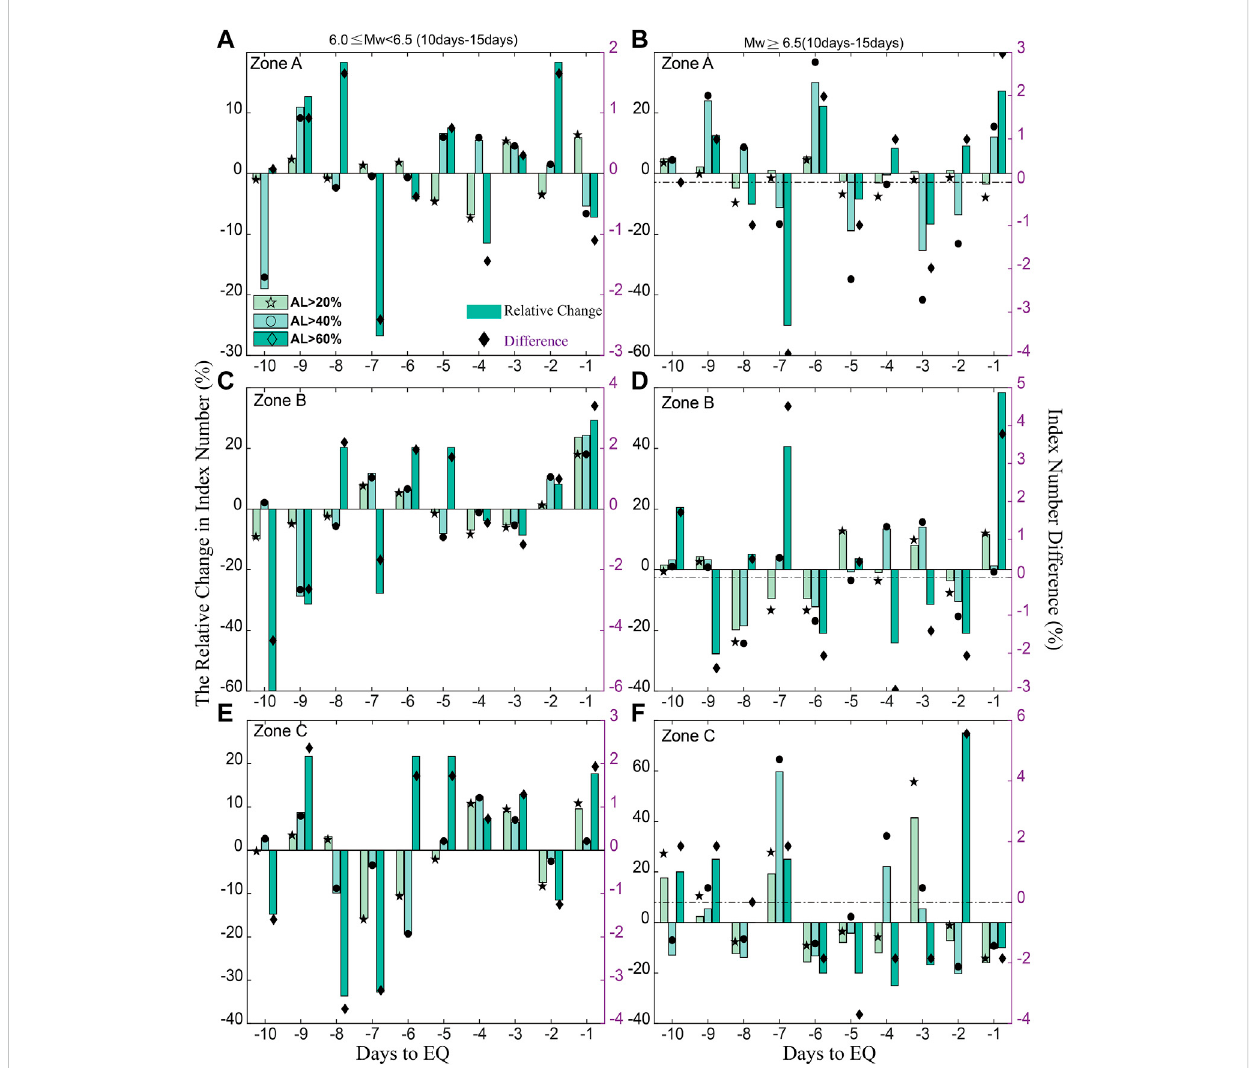
FIGURE 5 The differences and relative changes of the Index Numbers of the seismo-ionospheric anomalies between the results of 10-day and 15-day sliding windows. (A, C, E) represent the results of 6.0 ≤ Mw < 6.5 in Zone A, Zone B and Zone C, respectively. (B, D, F) represent the results of Mw ≥ 6.5 in Zone A, Zone B and Zone C,